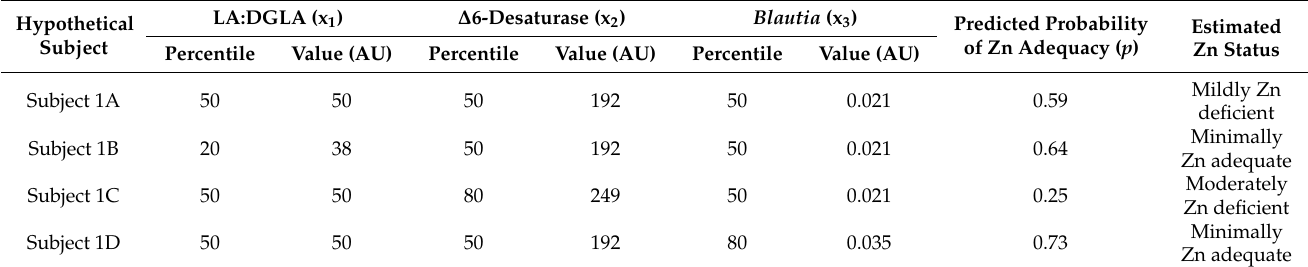
Table 6. Predicted probability of Zn adequacy of hypothetical subjects using the above ZSI example 1 1